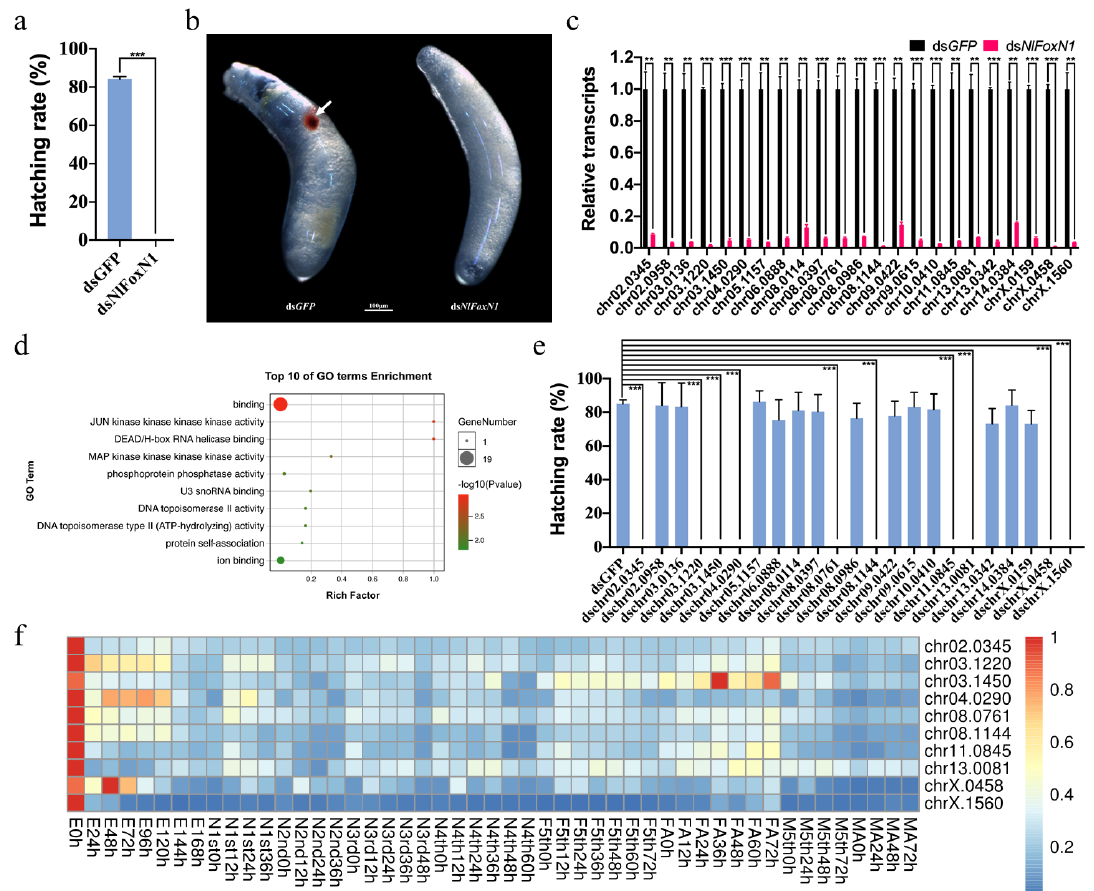
Figure 3. NlFoxN1 was indispensable for embryogenesis. ( a ) The hatching rate of the eggs after knockdown of NlFoxN1 . ( b ) The lethal phenotypes of eggs after knockdown of NlFoxN1 . The red eyespot was marked by the white arrow. ( c ) qPCR verification of the differentially expressed genes (DEGs). ( d ) Gene Ontology (GO) term enrichment analysis of the 23 verified DEGs in eggs. The GO enrichment study was performed using OmicShare tools. ( e ) The hatching rates of the eggs after knockdown of the 23 verified DEGs, respectively. ( f ) The temporal expression patterns of the ten potential targets. Heatmap was plotted using pheatmap R package based on the qPCR data from three biological replicates. dsRNA (50 ng per insect; n = 100) was injected into newly emerged female adults (within two hours). ds GFP was injected as a negative control for the nonspecific effects of dsRNA. Mean ± s.e.m. from three experiments. ** p < 0.01 and *** p < 0.001 (Student’s t -test), difference from ds GFP .